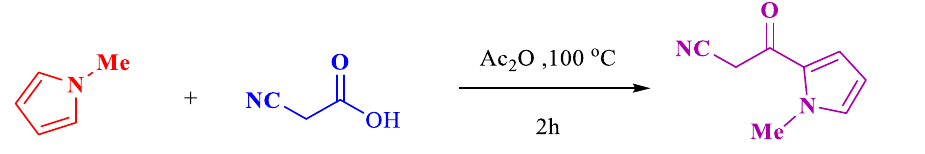
Figure 5. Preparation of 3-(1-methyl-1 H